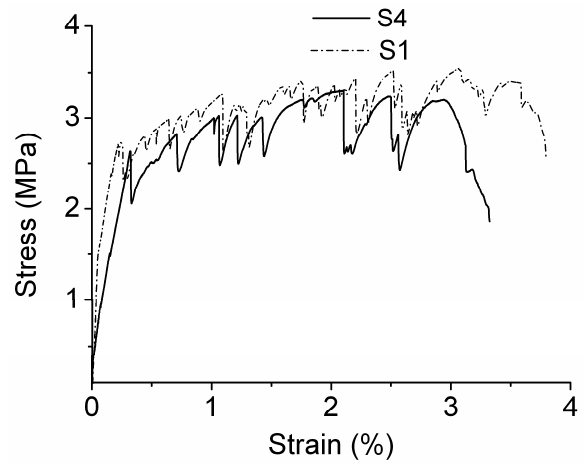
Figure 8. Stress-strain curve of S1 and S4.